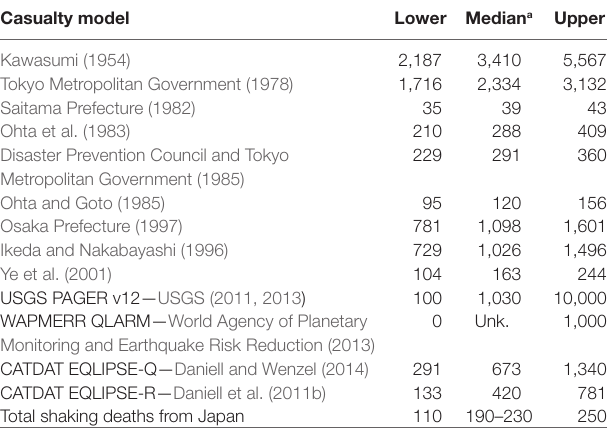
Table 9 | casualty range loss estimates from selected casualty models for the 2011 Tohoku eQ for earthquake shaking deaths. casualty model